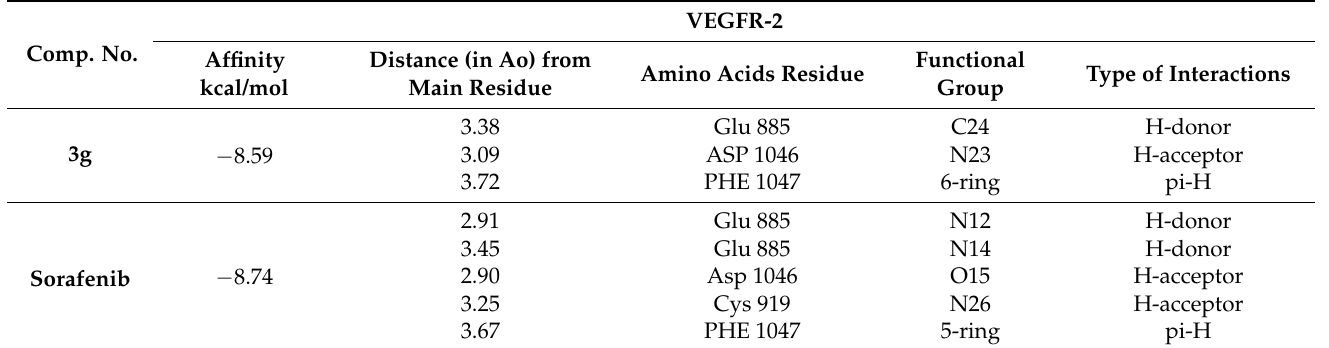
Table 2. Molecular docking data for compound 3g and Sorafenib in VEGFR-2 active site (PDB ID: 4ASD). Comp. No.